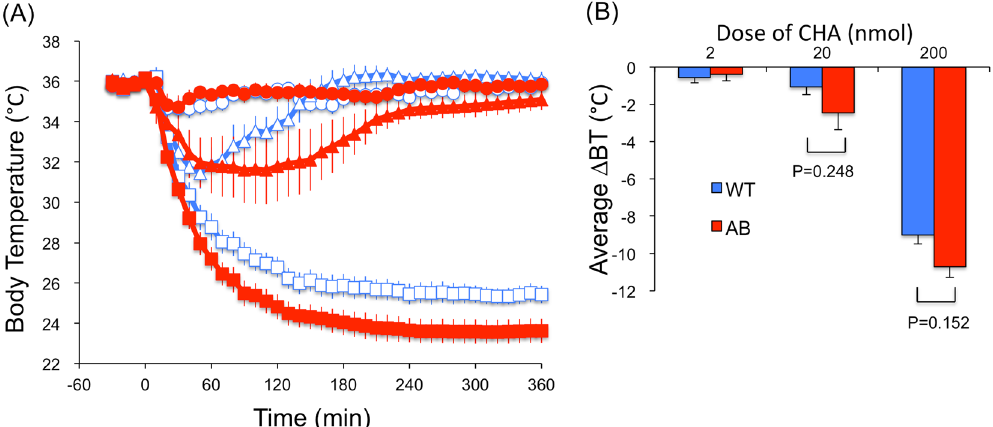
Figure 4. Effect of peripheral administration of an adenosine A1 receptor agonist, N6-cyclohexyladenosine (CHA), on body temperature. ( A ) Time-related changes in body temperature. Open symbols represent the data from wild-type mice (WT) and closed symbols from orexin neuron-ablated mice (AB). Circle, triangle, and square symbols indicate 2, 20, 200 nmol of CHA, respectively. CHA was intraperitoneally injected at time 0. ( B ) Changes in body temperature (BT) averaged for 6 hours after the injection. 2-way ANOVA indicated there was statistical difference among doses (F 2,30 = 160.0, p < 0.0001) but not between genotypes (F 1,30 = 4.11, p = 0.052). P values were calculated using the Holm-Sidak multiple comparison test. Each point represents mean ± SEM from 6